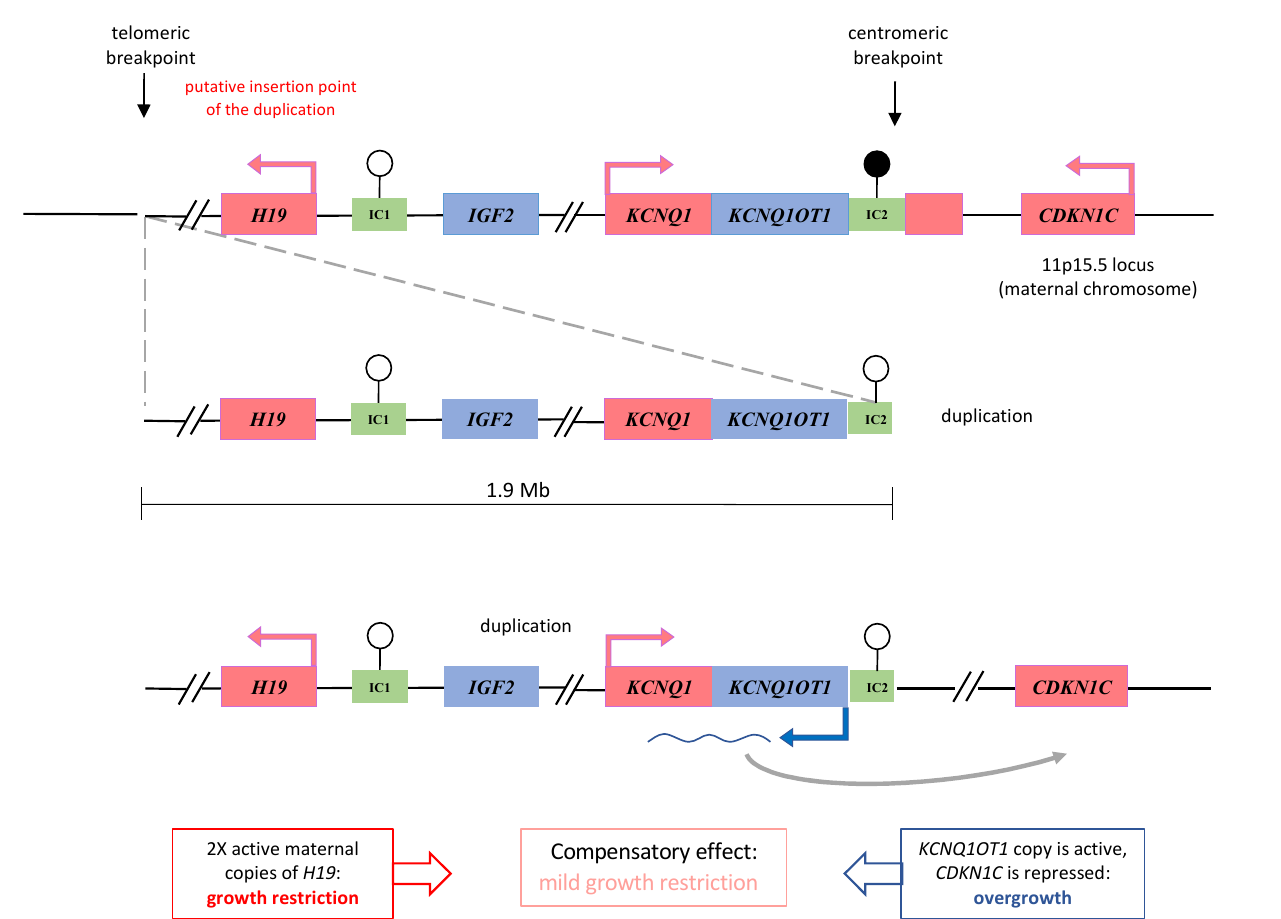
Figure 3. Diagram illustrating a hypothesis to explain the phenotype of the proband 1: a compensatory effect between growth stimulation deriving from IC2 LOM and growth inhibition caused by H19 duplication. The duplicated region is depicted separately from the chromosome and connected to the breakpoints by dashed lines. Black arrows indicate the genomic position of the breakpoints. Thicker dashed line represents the most probable location of the duplication to better explain the IC2 LOM. Rectangles represent maternally- (in red) and paternally- (in blue) expressed imprinted genes and imprinting centres (IC, in green). Black lollipops indicate methylated IC; white lollipops, unmethylated IC.